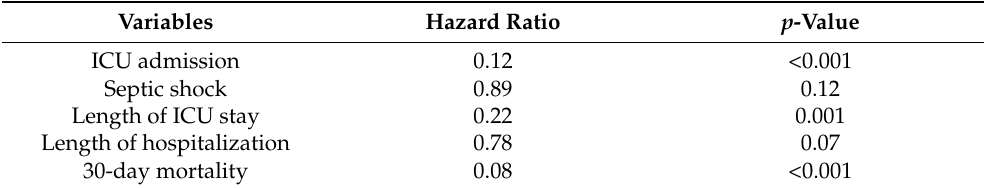
Table 4. Association between early effective antibiotic therapy and outcomes in all study patients.